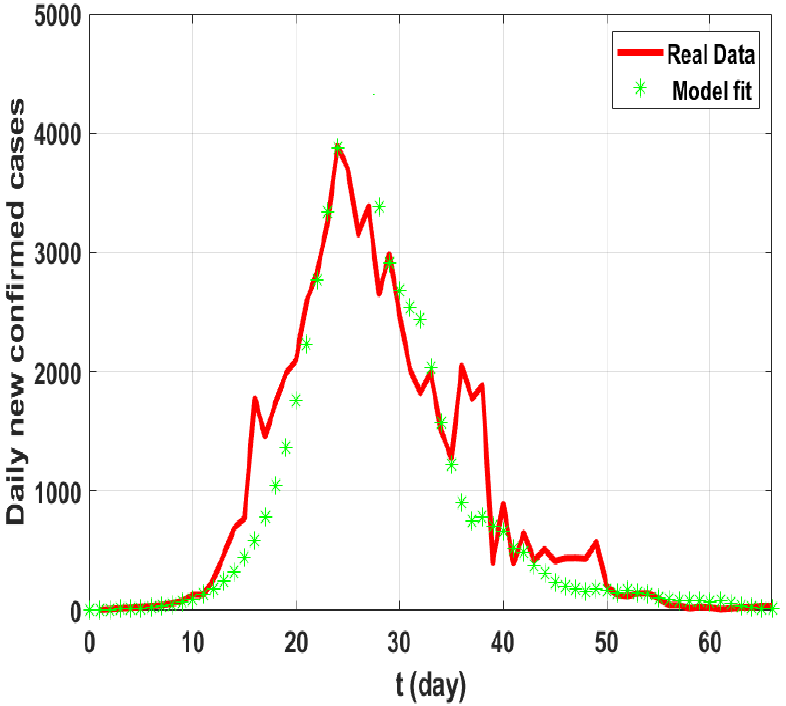
Figure 6. Numerical simulation for system (14–16) and the real data from Wuhan at H ∗ = 0.9, α = 0.975, α 1 = 0.978, σ 1 = 0.1, σ 2 = 0.3, σ 3 = 0.1, σ 4 = 0.01, σ 5 = σ 6 = σ 7 = σ 8 = 0.1 .